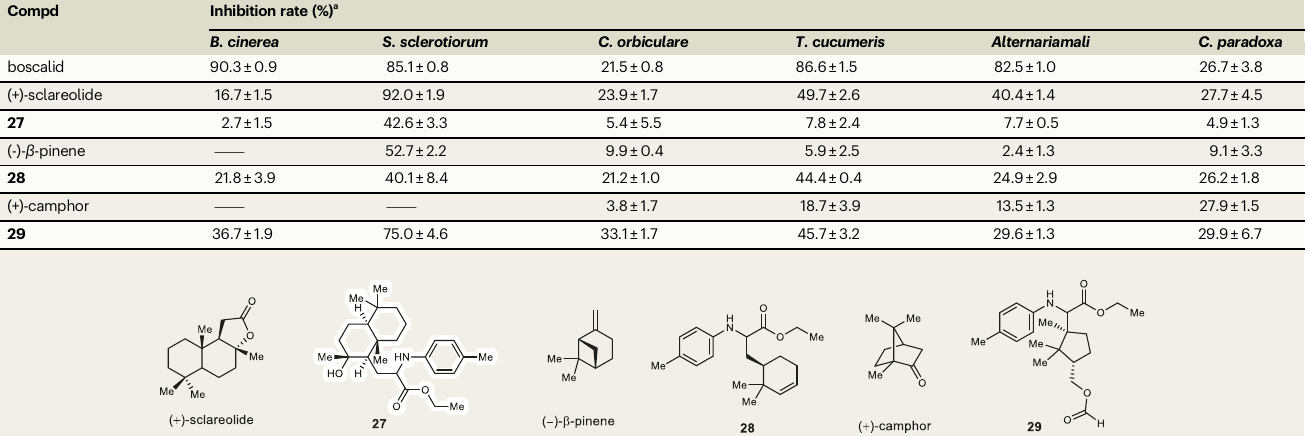
Table 2 | In vitro antifungal activities of the target compounds at 50.0 mg/L